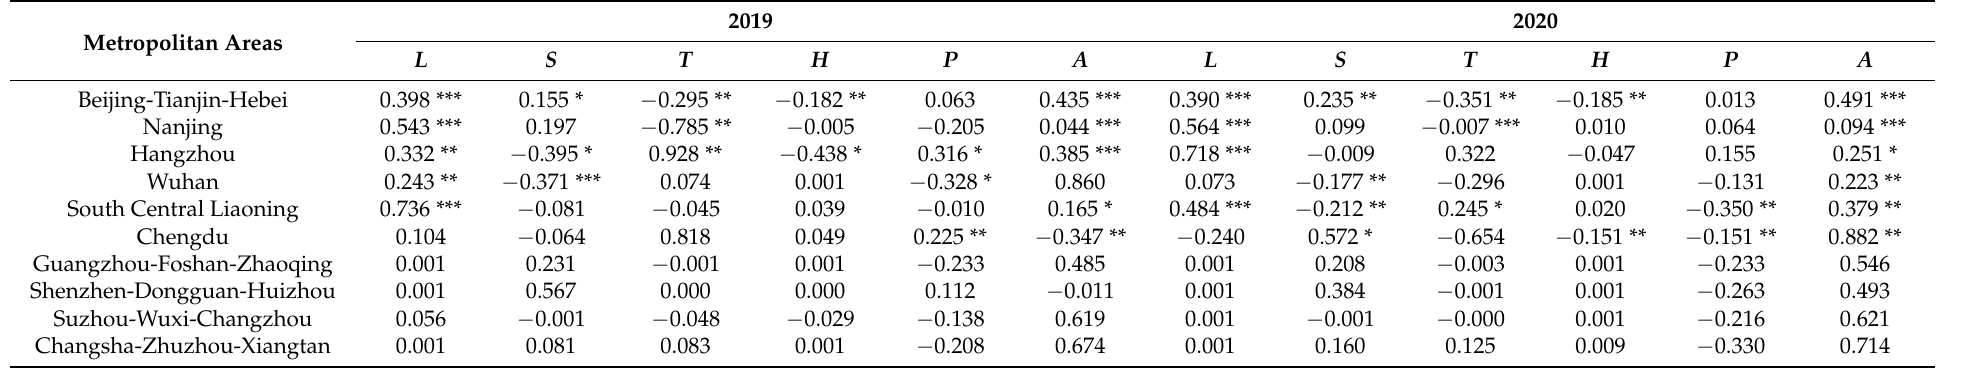
Table 5. QAP regression results for 2019 and